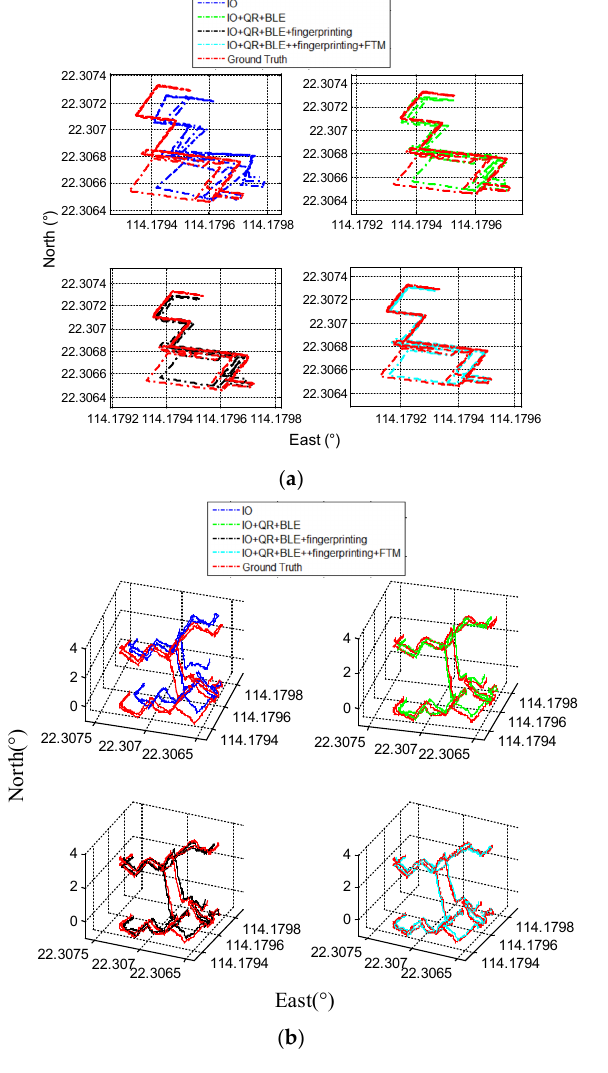
Figure 15. ( a ) Estimated 2D trajectories using inertial odometry and RUKF; ( b ) estimated 3D trajectories using inertial odometry and RUKF. Figure 15 indicates that that there was a cumulative error in inertial ranging as usage time grew, especially when the pedestrians walked across floors. The proposed 3D- WBQM framework significantly reduced the cumulative errors in inertial odometry by fusing multi-source information using a universal fusion approach. A comparison of the CDF errors between the two methods is shown in Figure 16.